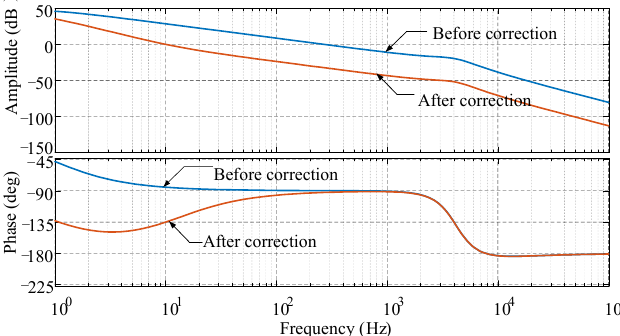
Figure 13. Open-loop Bode diagram of the voltage loop before and after correction.